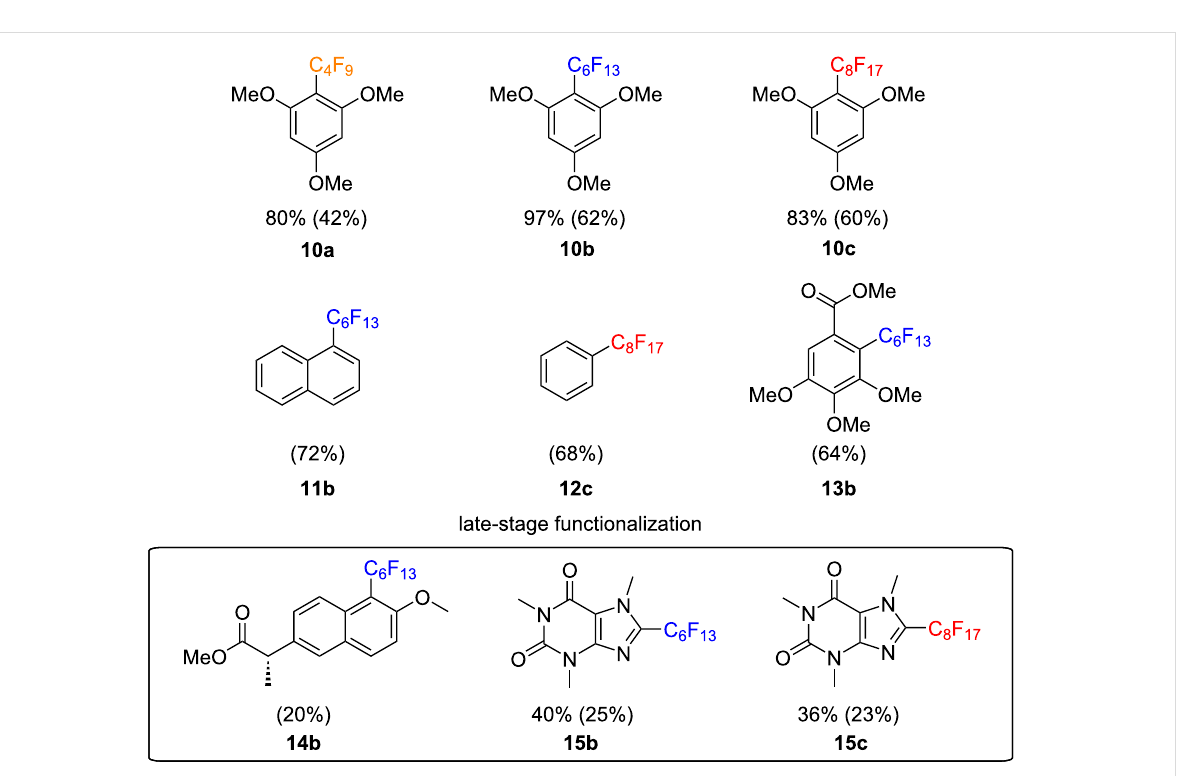
Scheme 5: Demonstrative scope for the perfluoroalkylation of aromatics. Isolated yields are shown in